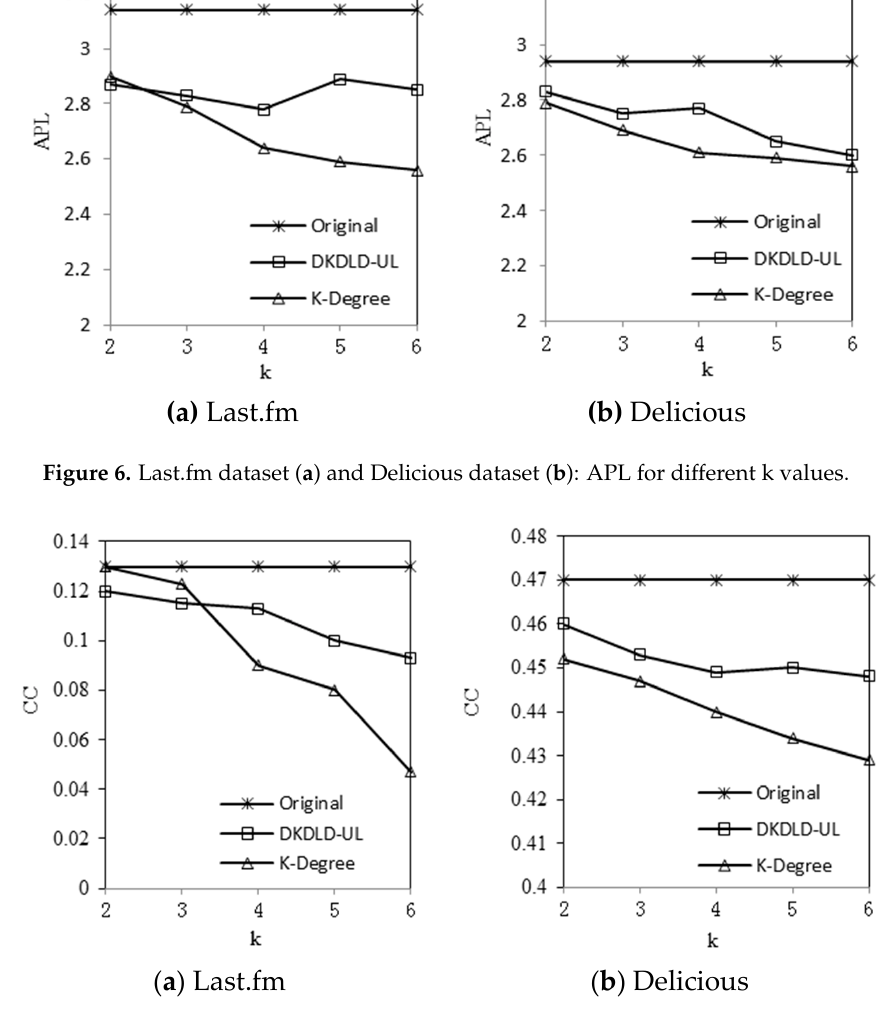
Figure 7. Last.fm dataset ( a ) and Delicious dataset ( b ): CC for different k values.